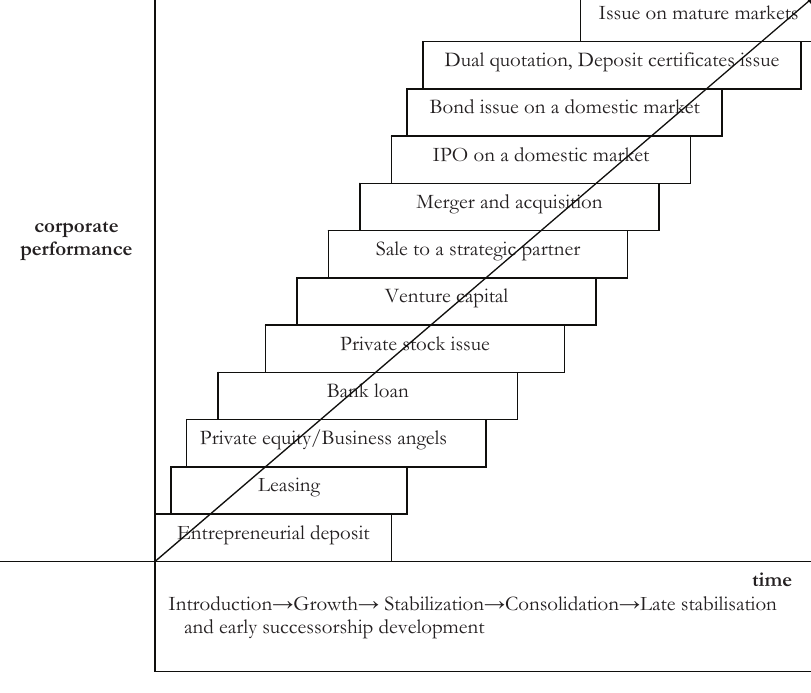
Fig. 1 – Possibilities of external financing of the company during the corporate life cycle. Source: Nývltová and Režňáková